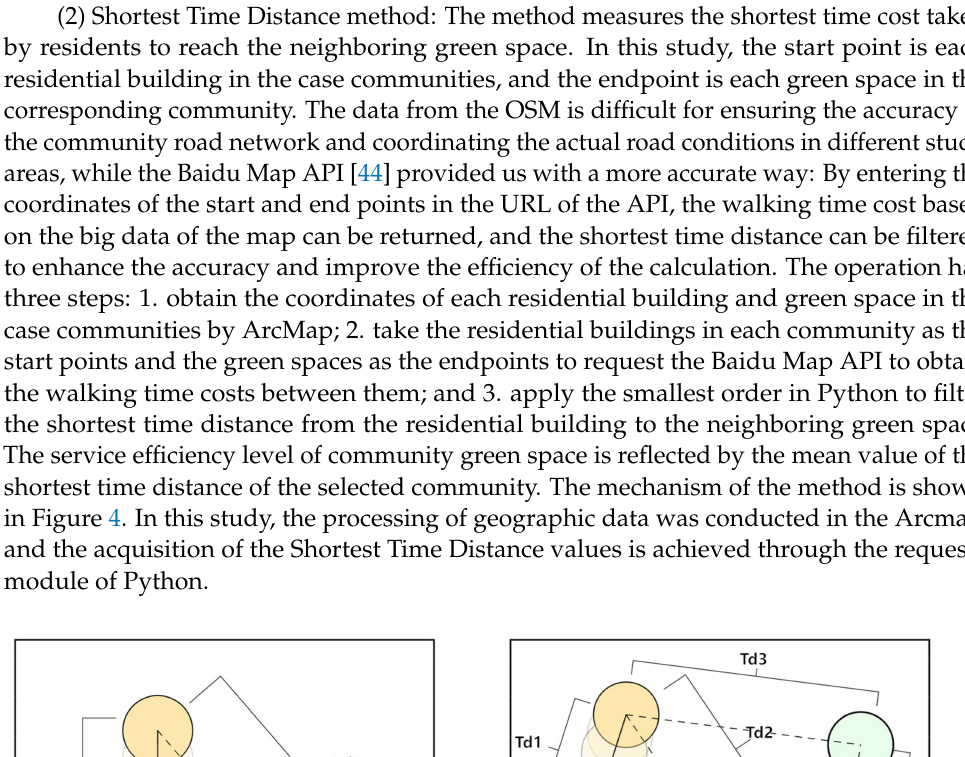
Figure 3. The mechanism of 2SFCA method.